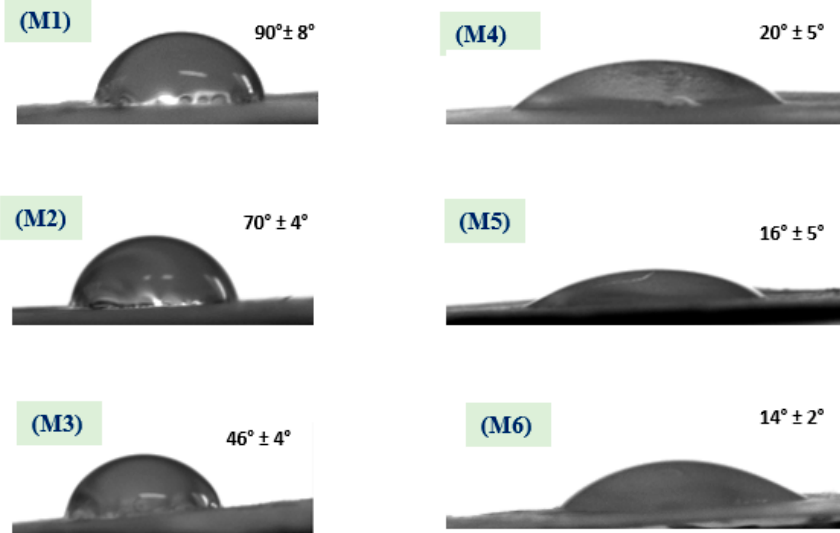
Figure 6. The water contact angle (WCA) of the different membranes shows a decrease in its values after NaOH